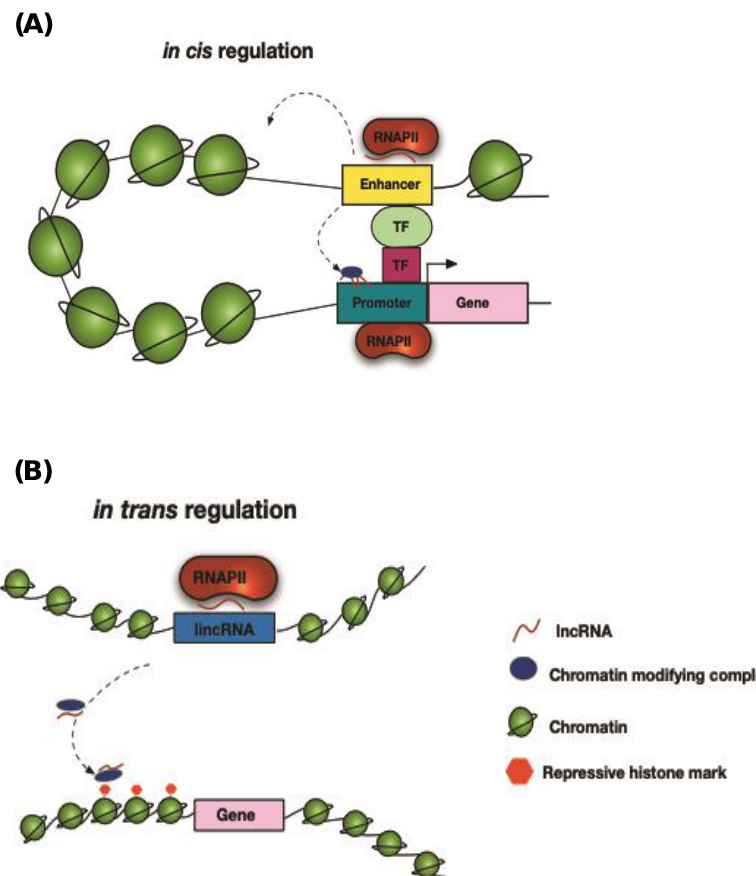
Figure 4. Long non-coding RNAs function in cis and in trans to regulate gene expression by interacting with chromatin remodeling factors and binding proteins in order to regulate the expression of ( A ) neighboring genes, in cis or ( B ) in trans, distally located genes that could be located on the same or a different chromosome. TF, transcription factor and RNAPII, RNA polymerase II.